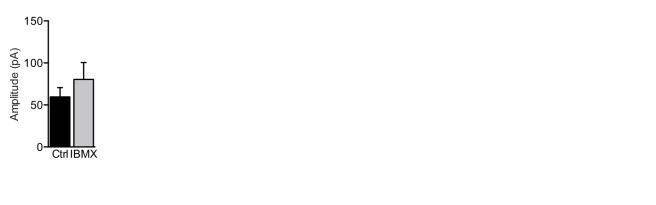
Blocking phosphodiesterase activity is not sufficient to induce significant AMPAR potentiation.Amplitudes of outside-out evoked recordings (from SEP-GluA3-positive neurons) in response to AMPA puffs in control condition (n=7) or in the presence of IBMX (n=3) (t-test, p=0.4). Error bars indicate SEM.